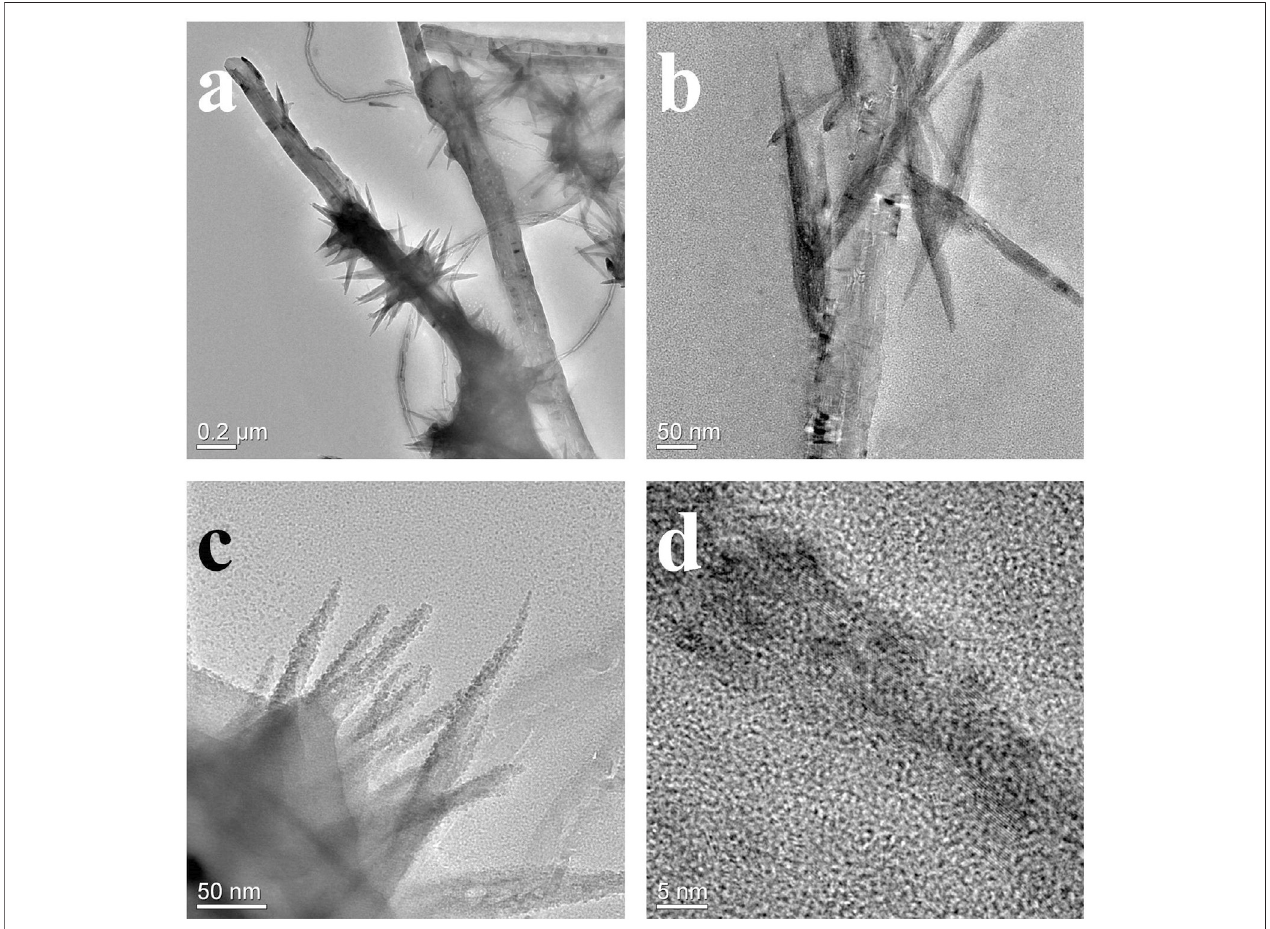
FIGURE 3 | TEM morphologies of CoNi2 basic carbonate nanowire/CNT paper composites (A, B) and the CoNi2 basic carbonate nanowire structures (C, D) .